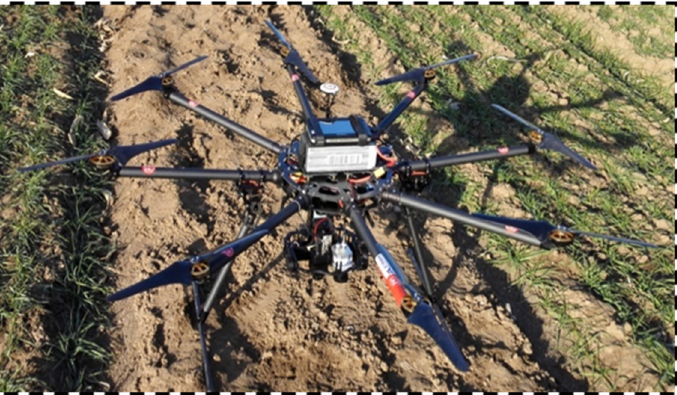
Figure 1. The UAV platform for simultaneously mounting the HD digital and TIR cameras.